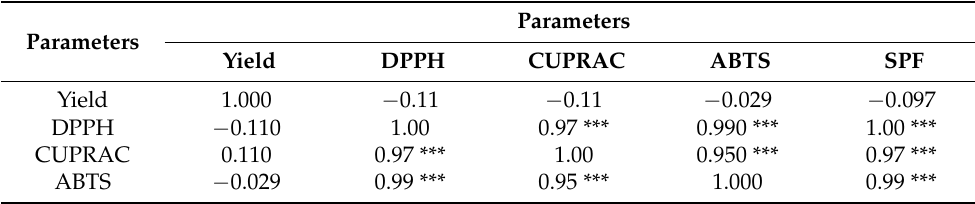
Table 4. The Pearson correlation coefficient among yield, antioxidant capacity, and SPF value of phytosomes (*** p < 0.001).